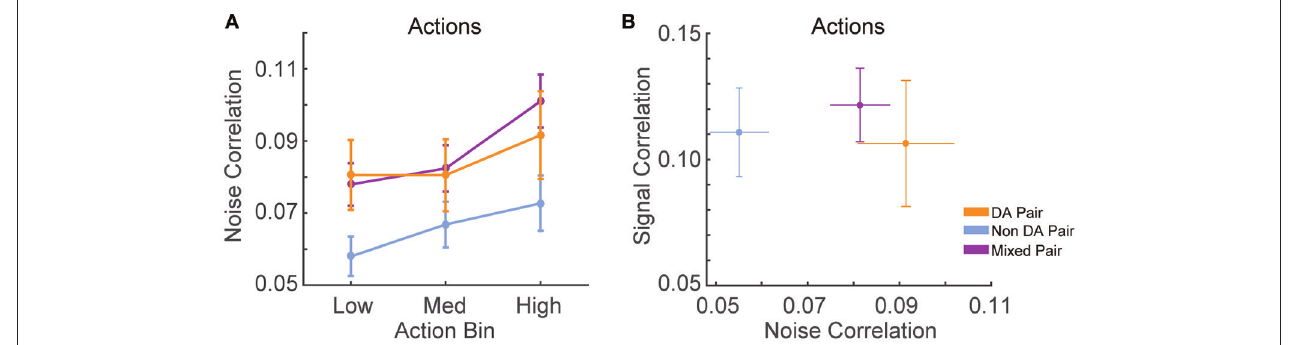
FIGURE 5 | Correlation structure of RR10 action-evoked responses. (A) Mean ± SEM action evoked noise correlations between simultaneously recorded pairs of VTA neurons in RR10 sessions during actions. Noise correlations measure trial-by-trial fluctuations in pairwise activity. Data depicted as mean ± SEM noise correlation in each bin of actions. Data are plotted separately for all pairings of VTA neurons. (B) Mean ± SEM signal correlation (correlation between tuning curves) and noise correlations during RR10 actions. For simplicity, noise correlations are collapsed across action number bin.